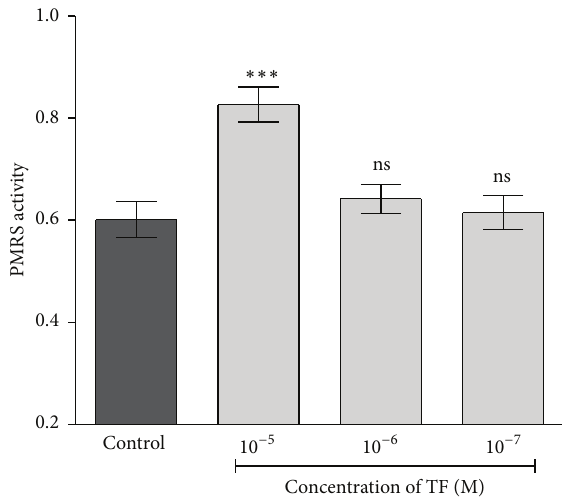
Figure 4: Dose-responsive effect of theaflavin on PMRS in ery- throcytes isolated from rat blood. PMRS activity expressed in terms of micromole ferrocyanide/mL PRBC/30min. ∗∗∗ 𝑃 < 0.001 as compared with